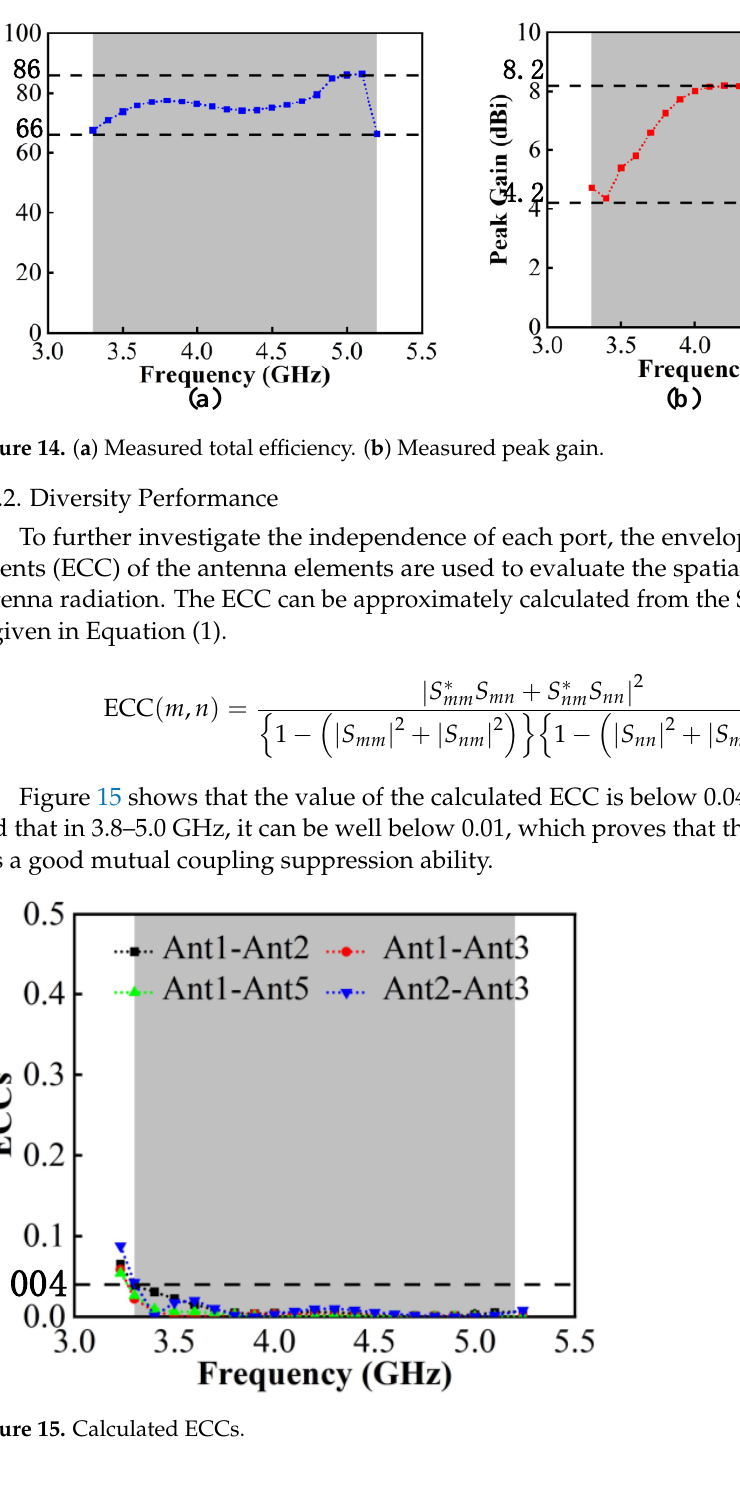
Figure 14. ( a ) Measured total efficiency. ( b ) Measured peak gain.